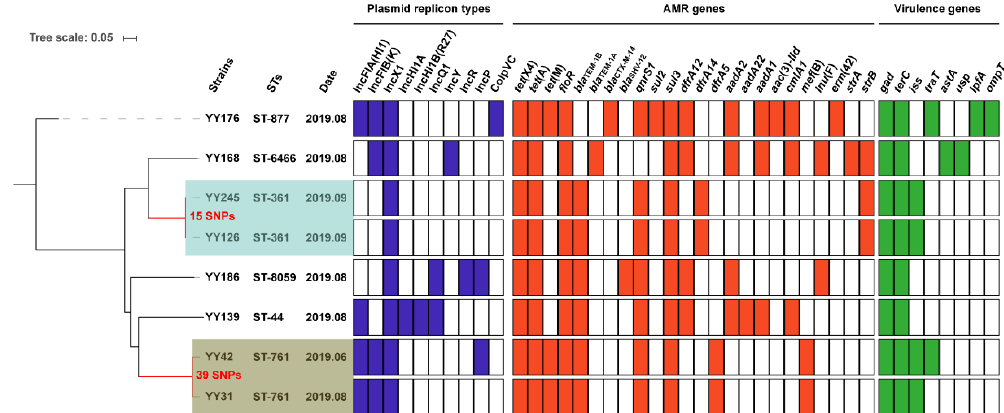
Figure 1. The phylogenetic tree and genomic features of eight tet (X4)-positive E. coli isolates. On the phylogenetic tree, the light blue and light brown color ranges reflect the two clonal groups. The heatmap in different colors depicts the presence or absence of the plasmid replicon types (blue), antimicrobial-resistance (AMR) genes (red), and virulence genes (green).